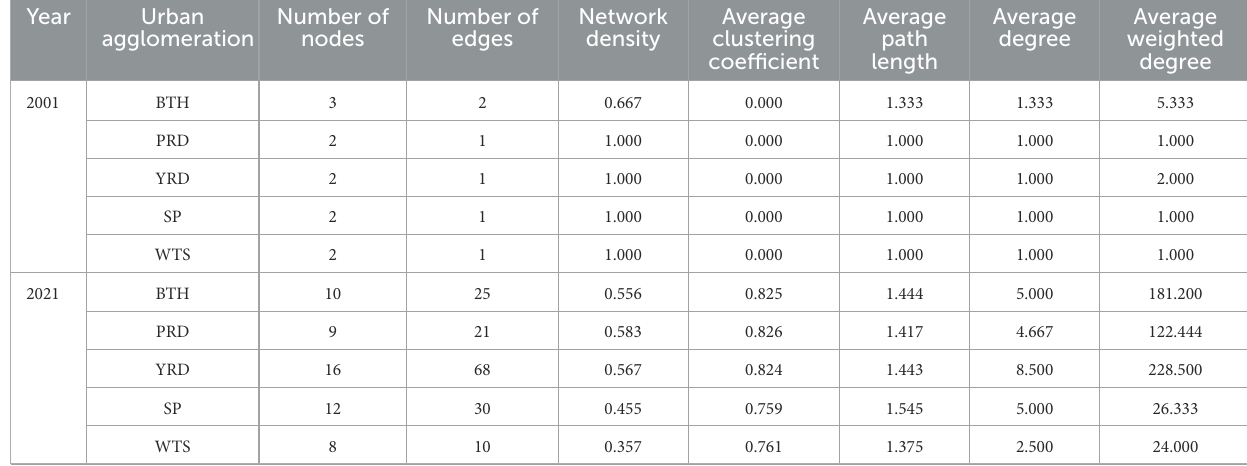
TABLE 11 Statistical characteristics of the low-carbon patent cooperation networks of the five urban agglomerations along the eastern coast of China.